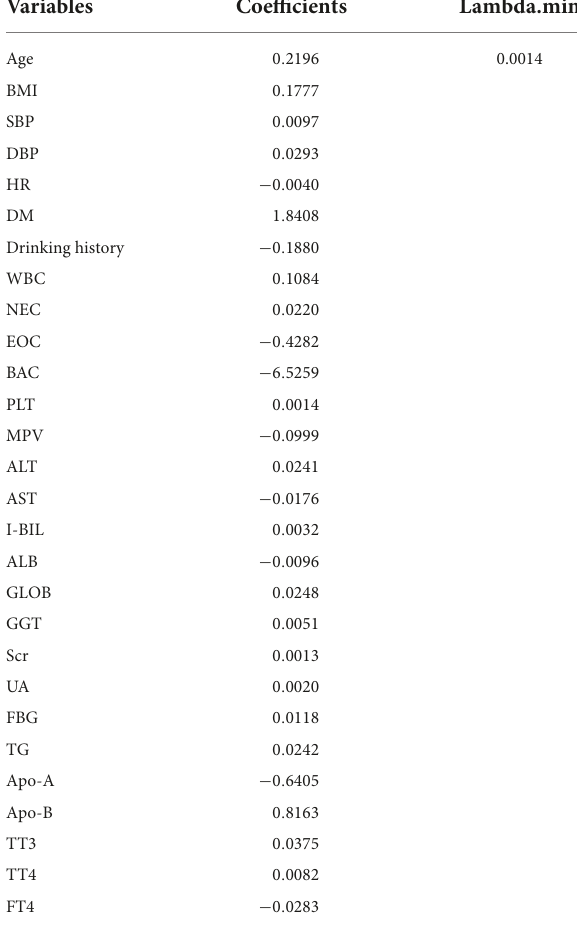
TABLE 4 Coefficients and lambda.min value of the LASSO